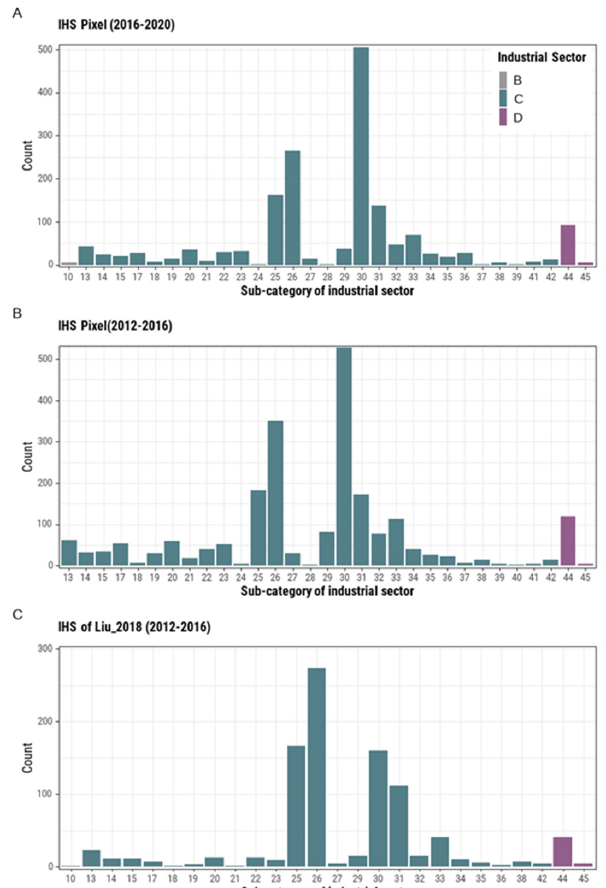
Figure 7. The composition of the subcategorical industry sectors fell in the industrial heat source (IHS) pixels of 2016–2020 ( A ). As a comparison, we also listed the composition for IHS pixels of 2012–2016 ( B ) and the Liu_2018 data ( C ). Details of each sector can be found in Appendix A Table A1.